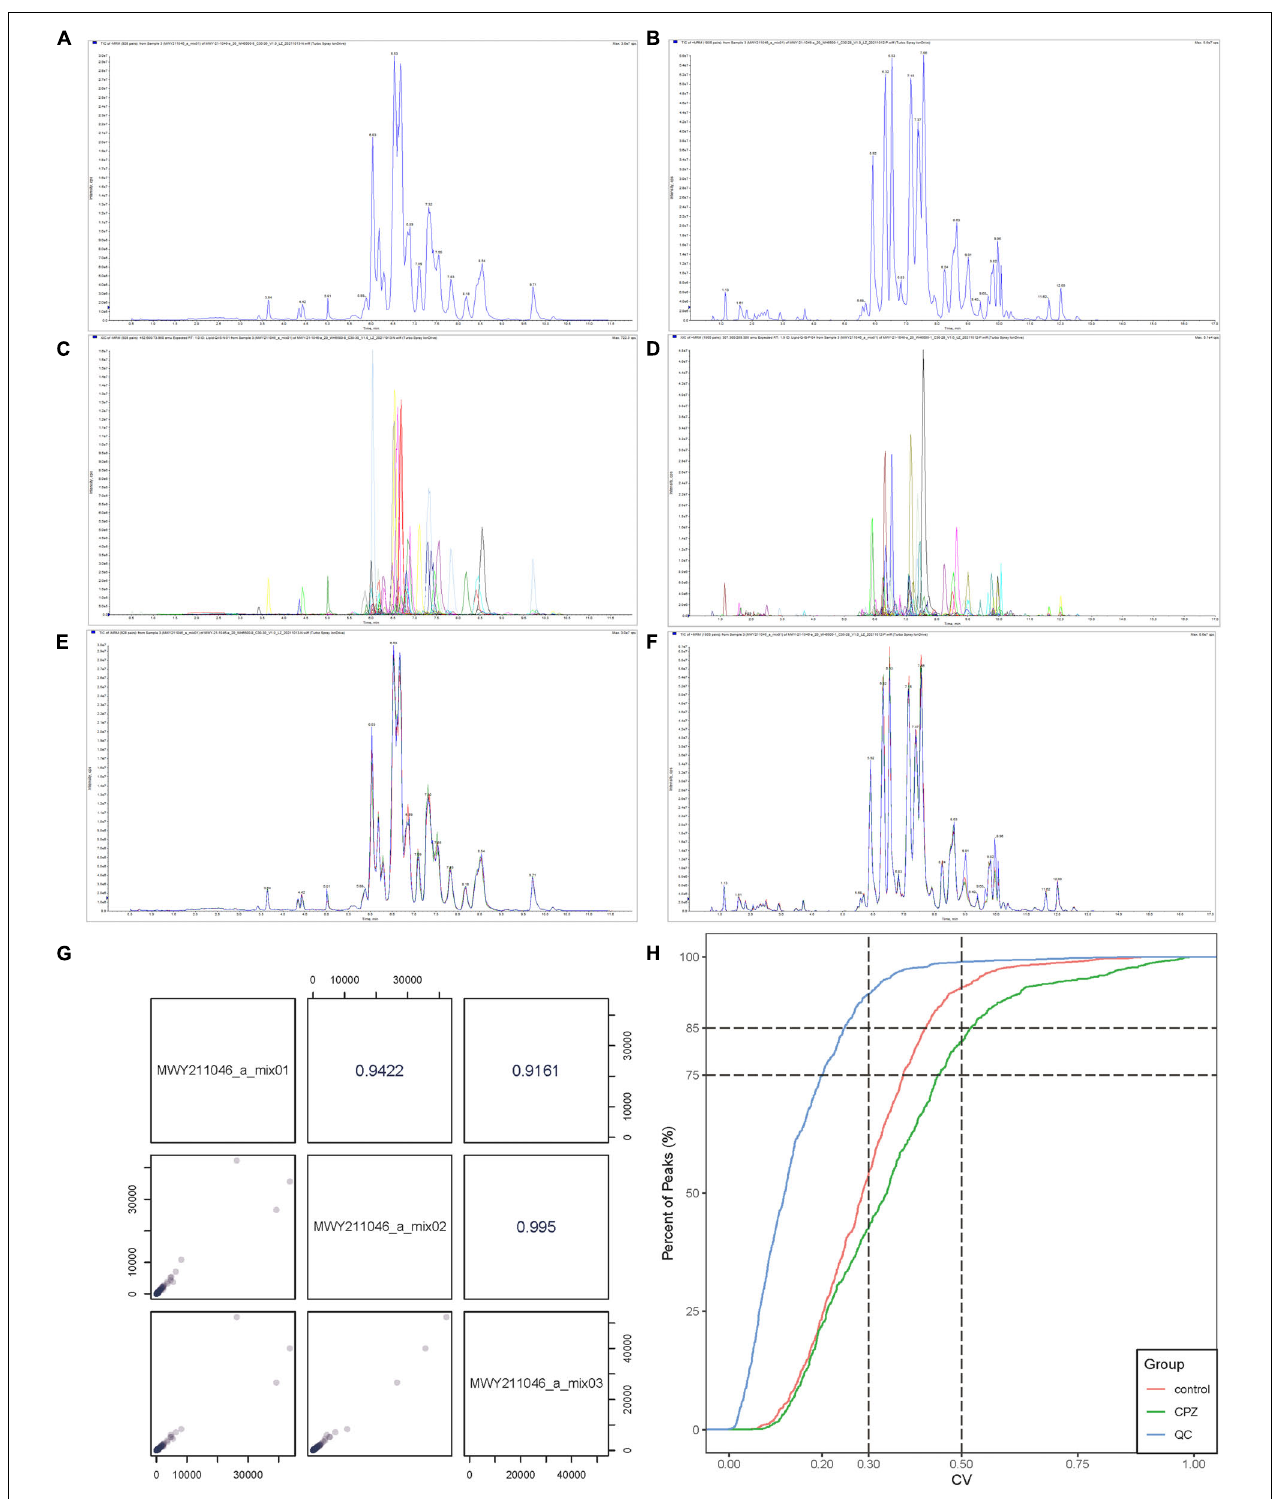
FIGURE 1 | (A) The TIC of mixed QC sample in negative mode. (B) The TIC of mixed QC sample in positive mode. (C) The MRM of mixed QC sample in negative mode. (D) The MRM of mixed QC sample positive mode. (E) The overlapping curve of TIC in negative mode. (F) The overlapping curve of TIC in positive mode. (G) The correlation analysis diagram of QC samples. (H) The CV diagram of QC